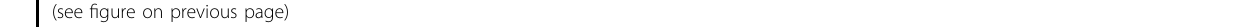
Fig. 4 Highly represented related networks of molecular, cellular, and development pathways show cytokine (storm) network and innate immunity in coronavirus-infected patients. A REACTOME 28 database-based connection of different but related pathways that were enriched (hypergeometric test of FDR < 0.2 and overlap a similar index of 0.5 using hypeR 57 ) in infected patients using network plots. B KEGG 60 pathways- based network showing enrichment (hypergeometric test of FDR < 0.2 and overlap a similar index of 0.25 using hypeR 57 ) of different diseases and infection related pathways. For A and B , nodes and edges are of same size and length, respectively. C Enrichment statistical analysis (hypergeometric test of FDR < 0.2 using hypeR 57 ) using CoV-Up-gene signature and pathways/processes based on gene sets from COMPARTMENTS database 61